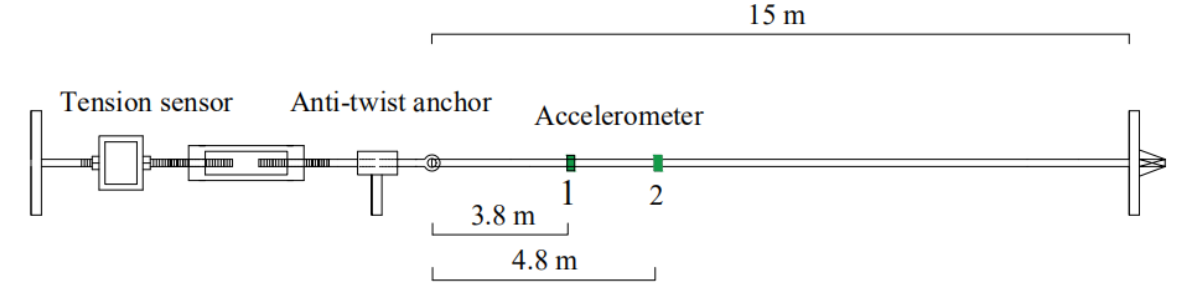
Figure 1. Design drawing of the stay cable in the scale model experiment.